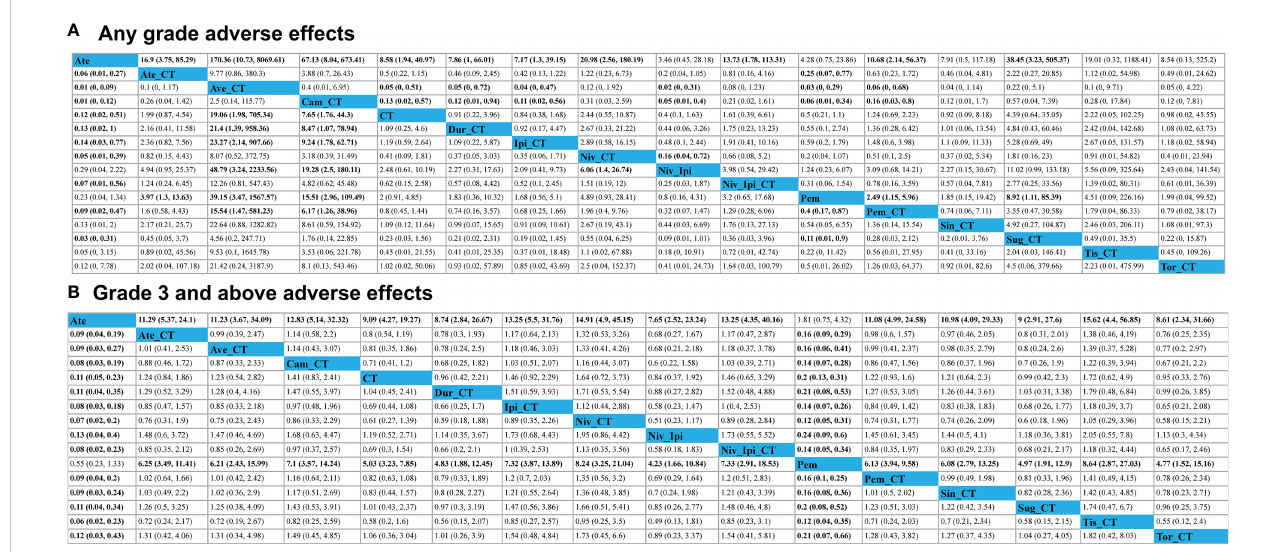
FIGURE 4 Safety pro fi les for adverse events of any grade (A) or adverse events of grade 3 or higher (B) . Each cell (light gray) in the safety pro fi le includes pooled odds ratios and 95% con fi dence intervals, with signi fi cant results being shown in bold red text signi fi cant results are in bold. Pooled odds ratios and 95% con fi dence intervals correspond to outcomes for the upper treatment tier relative to the lower tier.